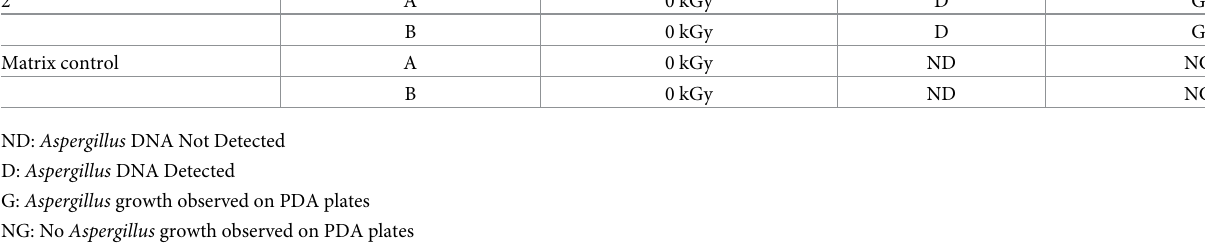
exposed to 2.5 kGy of X-rays showed no A . niger viability, while those without X-ray exposure had Aspergillus growth, See Table 7.